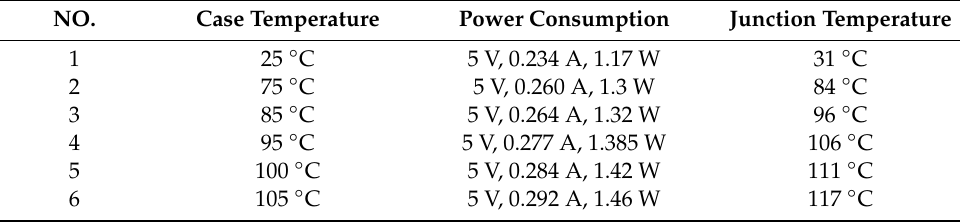
Table 3. High temperature test situation of SiP chip (Zynq) thermal